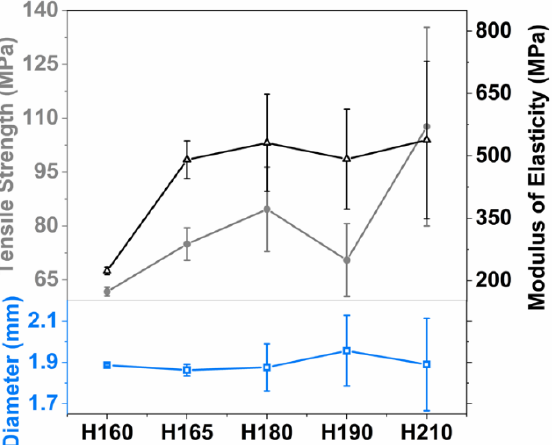
Figure 1. Mechanical properties and diameters of the filaments with varying HME processing temperatures, ranging 160–210 °C.